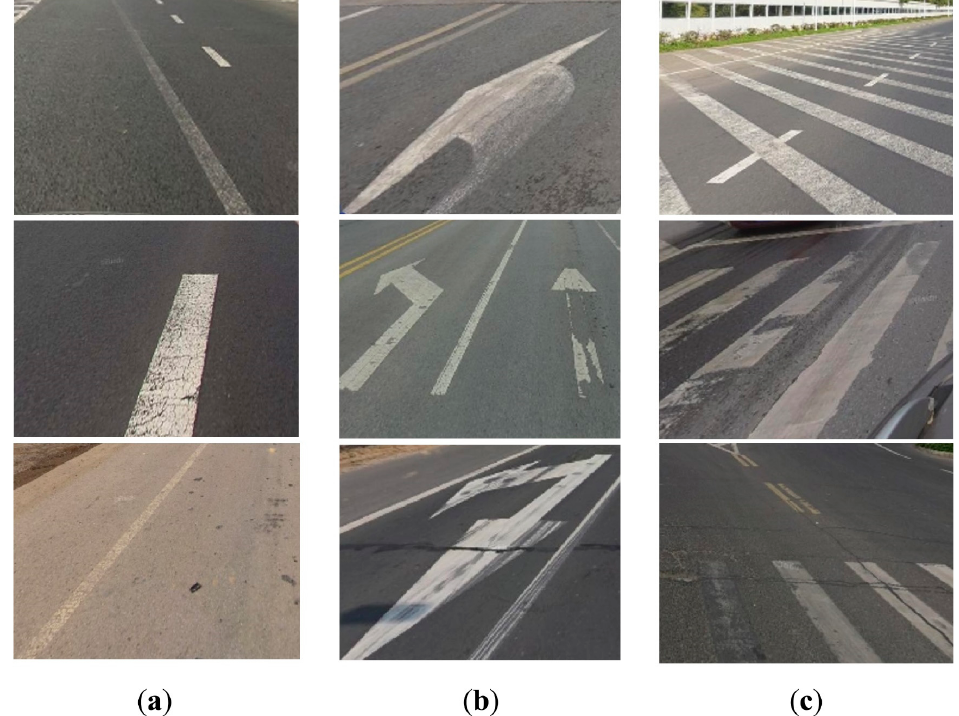
Figure 1. Examples of pavement-marking defects on the road. ( a ) Line-type marking defects, ( b ) arrow-type marking defects, ( c ) evenly-spaced-type marking defects.